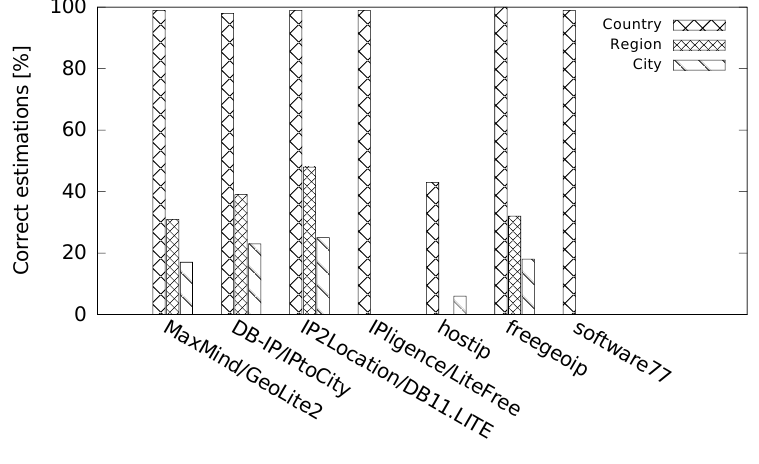
Figure 10. Correct discrete